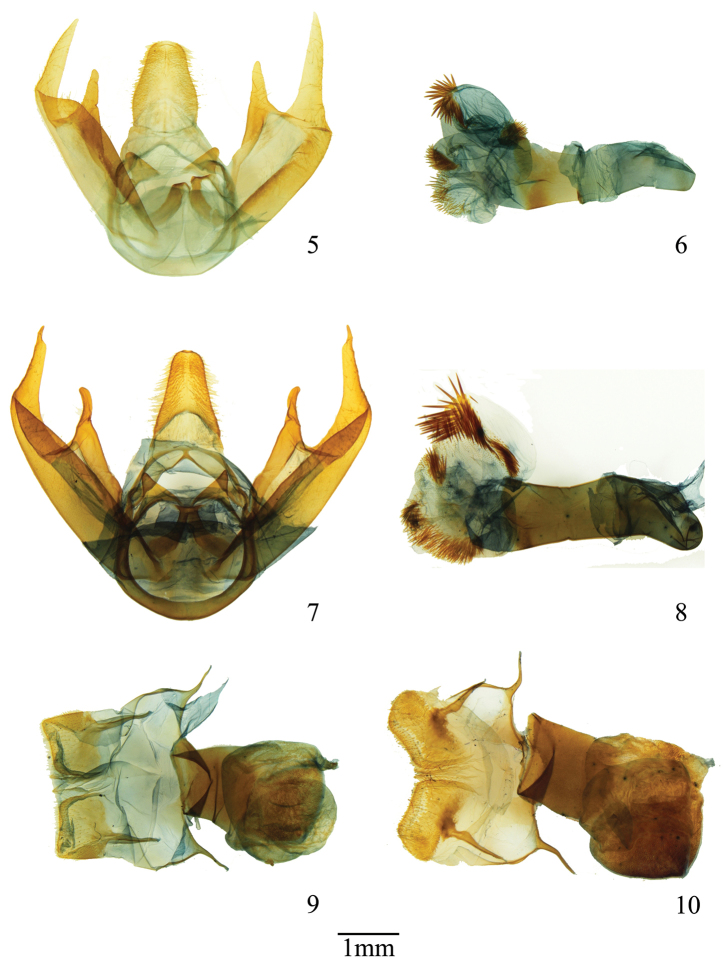
Genitalia male and female of Lophocampa species. 5–6Lophocampaazuayensis sp. n genitalia (5), penis (6), holotype male 7–8Lophocampacarpishensis sp. n., genitalia (7), penis (8), holotype male; Lophocampaazuayensis sp. n genitalia female (9); Lophocampacarpishensis sp. n., genitalia female (10).